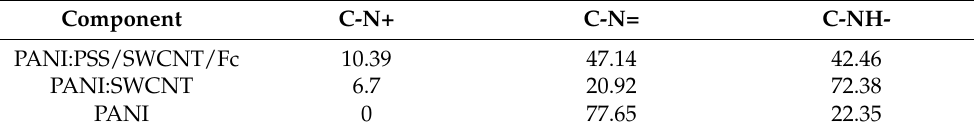
Table 3. The component for N1s.